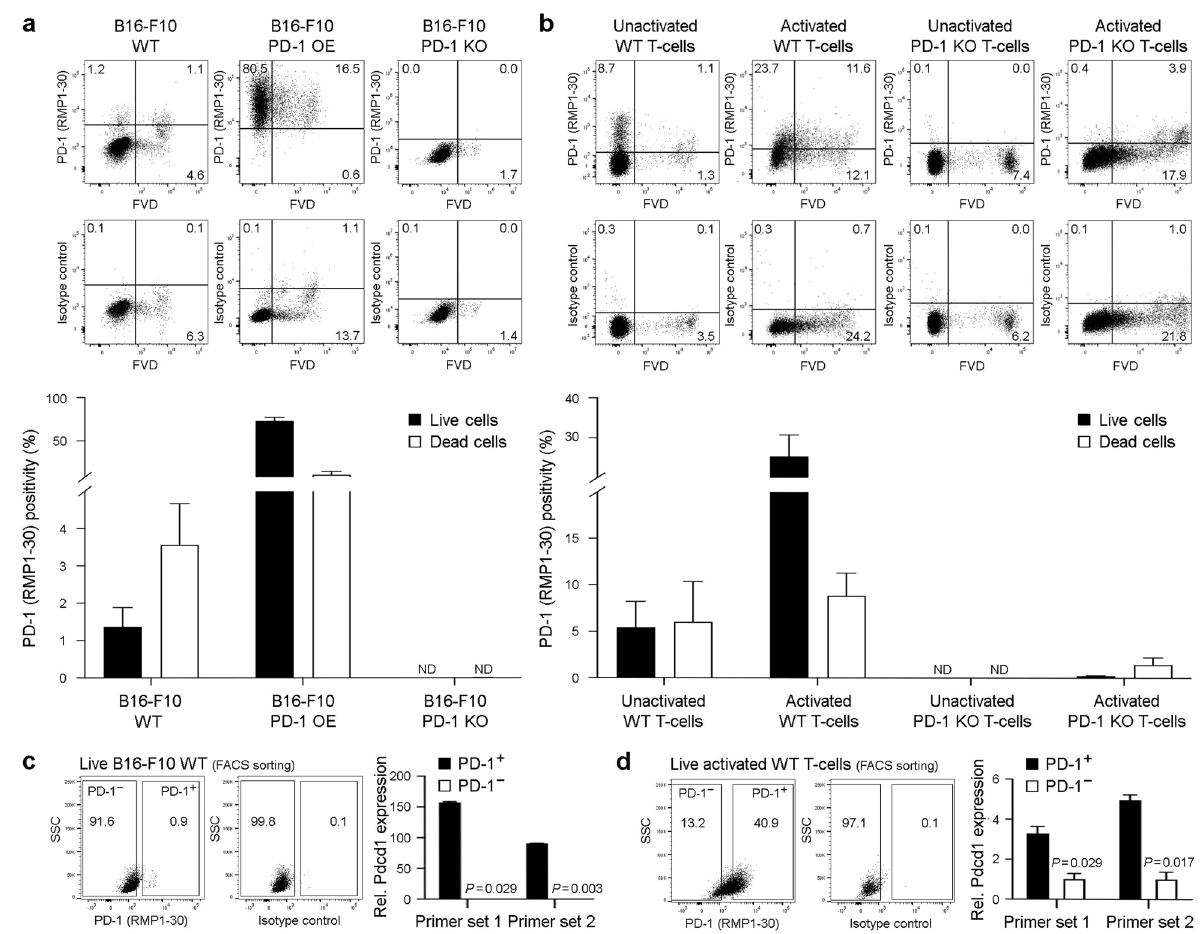
Figure 3. The anti-PD-1 RMP1-30 monoclonal antibody recognizes PD-1 surface protein on live B16-F10 melanoma cells. ( a,b ) Representative FACS plots of surface PD-1 protein expression (clone RMP1-30) or isotype control staining and % positivity (mean ± s.e.m.) on live versus dead (fixable viability dye, FVD-negative or -positive, respectively) ( a ) B16-F10 wild-type (WT), PD-1-overexpressing (OE), or PD-1 knockout (KO) melanoma cells, or on ( b ) unactivated versus activated WT or PD-1 KO T-cells (C57BL/6), respectively. ( c,d ) Relative Pdcd1 expression (mean ± s.d., two distinct primer sets), as determined by real-time qPCR (right), in FACS-sorted (RMP1-30, left) live (FVD − ) ( c ) PD-1 + versus PD-1 − B16-F10 WT melanoma cells or ( d ) respective activated WT (C57BL/6) T-cell subsets. All results are representative of at least n = 3 independent experiments. * p < 0.01; ** p < 0.01; ND, not